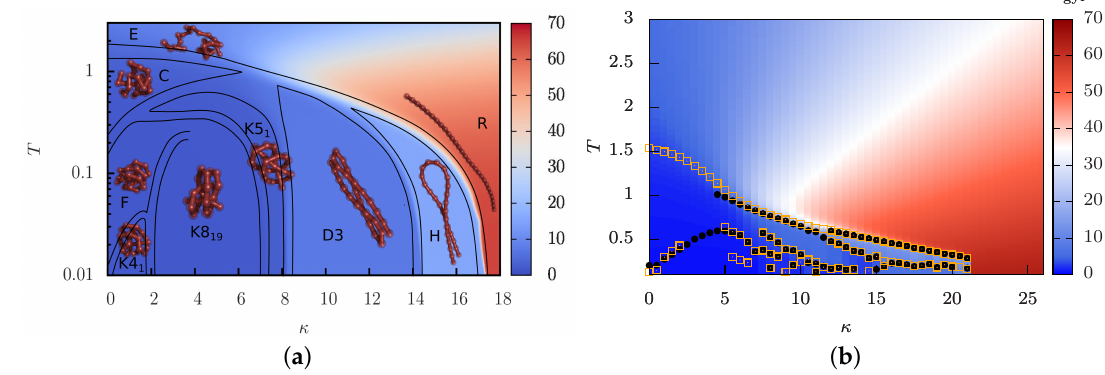
Figure 1. Comparison of structural phase diagrams for a single semiflexible polymer with self-attraction: ( a ) bead-stick polymer ( N = 28, logarithmic temperature scale, adapted from [98]); and ( b ) bead-spring polymer ( N = 40, linear temperature scale from parallel multicanonical simulations). Black circles and orange squares correspond to peak positions of C V and dR 2 gyr / dT , respectively. The background color encodes the squared radius of gyration, i.e., the polymer extension. Representative conformations are shown for the bead-stick polymer in the respective regimes and are similar in both cases, except for the knotted regimes (bead-stick) and toroidal regimes (bead-spring [97]). The collapse transition line is here denoted as all initial temperature-driven transitions from an extended structure into a compact